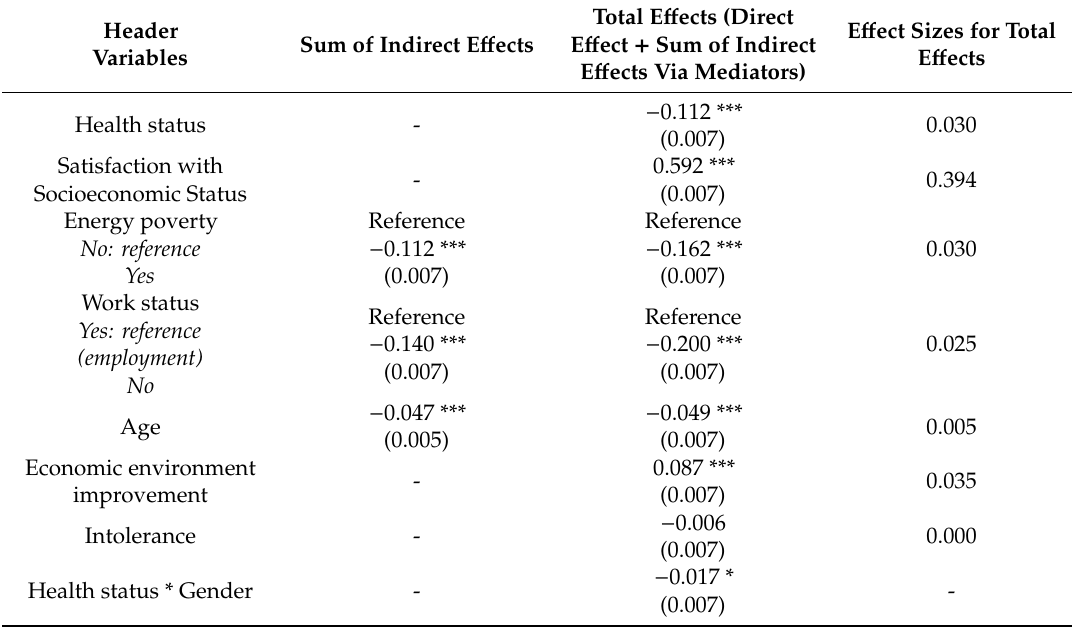
Table 5. Indirect and total e ff ects on life satisfaction and total e ff ect sizes.